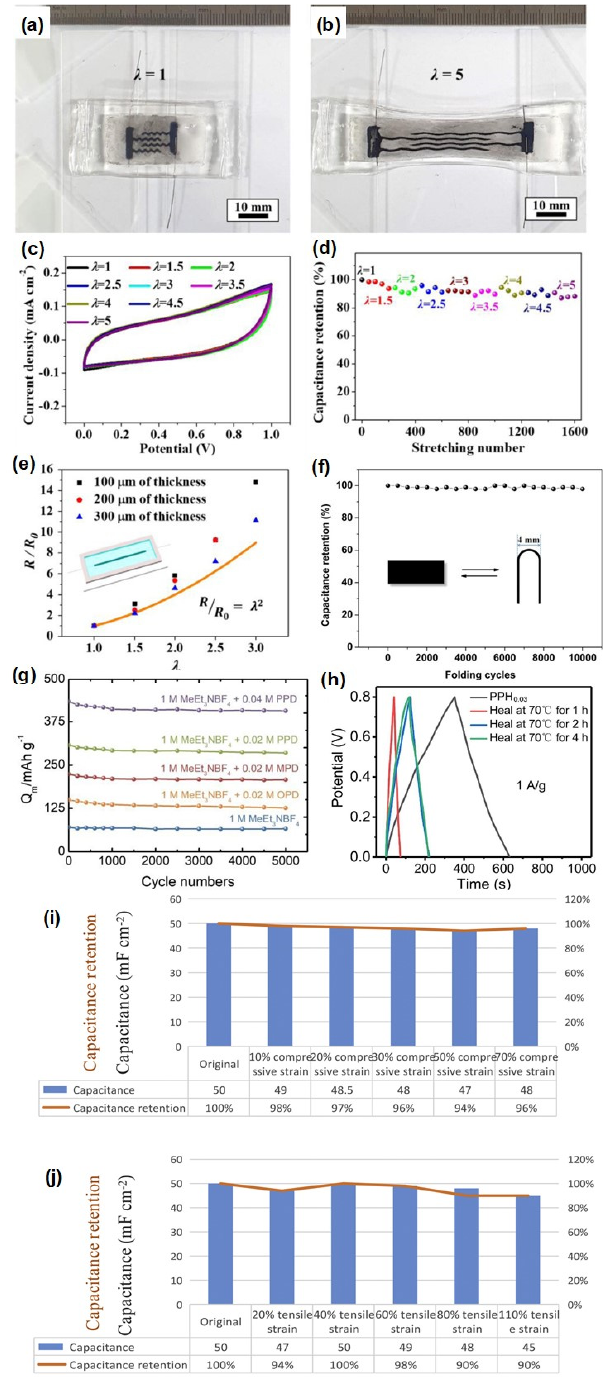
Figure 4. Effect of retention of diethylene glycol in the supercapacitor after printing. Photographs of the supercapacitor in ( a ) unstretched state and ( b ) stretched state ( λ = 5). ( c ) CV profiles of the supercapacitor at different stretching amplitudes. ( d ) Capacitance retention of the supercapacitor after different stretching cycles. ( e ) Change in the resistance (R/R 0 ) of the printed electrode as a function of the uniaxial stretching amplitude. The inset shows the schematic of the sample [44]. ( f ) Change in ca- pacitance of PPy-CPH hydrogel-based supercapacitor as a function of folding cycles [45]. ( g ) Change in capacitance of graphene hydrogel using phenylenediamine-based supercapacitor [46]. ( h ) Change in electric potential of a self-healable supercapacitor using all-hydrogel materials [47]. Change in capacitance of all-in-on hydrogel supercapacitor under ( i ) compressive and ( j ) tensile strain [48]. Reproduced with permission from ref.